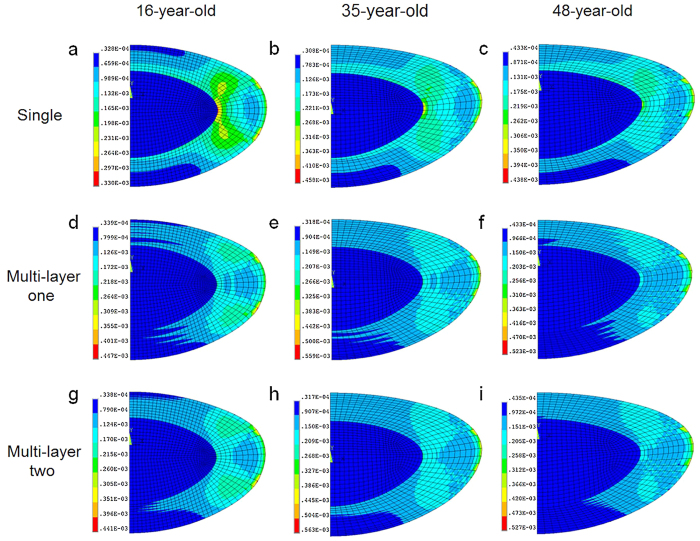
Stress patterns (as von Mises stress in MPa = N/m2 × 106) for human lens models aged 16, 35 and 48 based on optical measurements20 and using material properties of Fisher8.